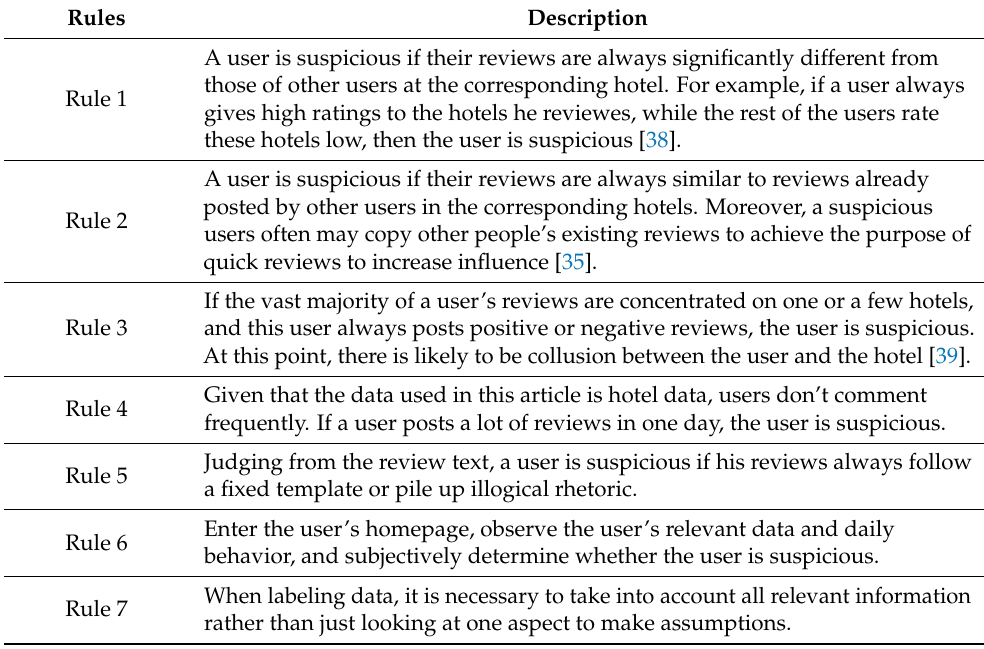
Table 3. Labeling